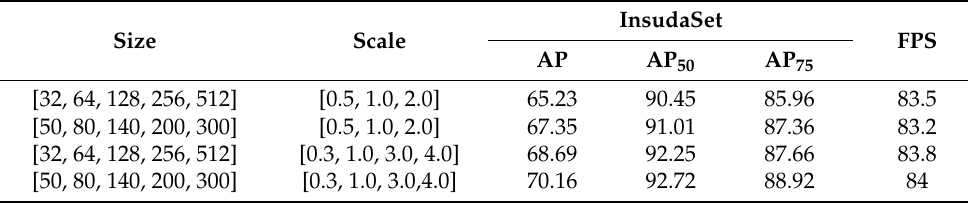
Table 7. Comparison table of results for setting different anchor box sizes and aspect ratios.